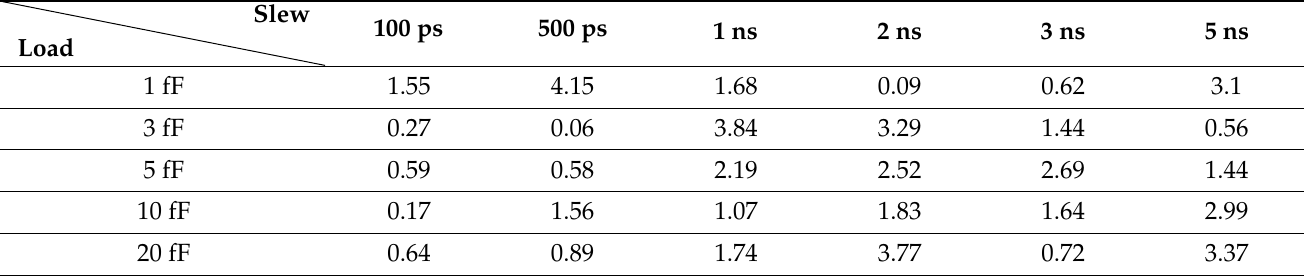
Table 1. Standard deviation error with the proposed model for INV (%).